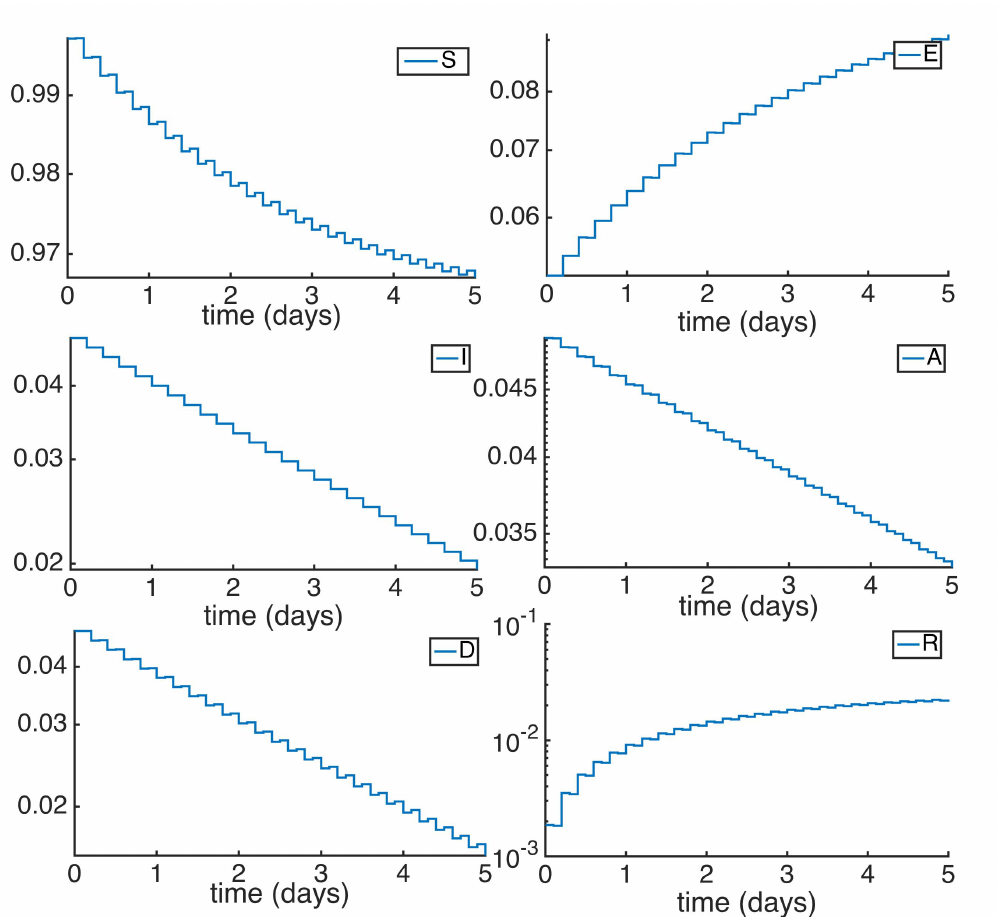
Figure 2. A detailed display of the reaction of the different subpopulations during the first days after the introduction of the disease given a R 0 = 0.81.